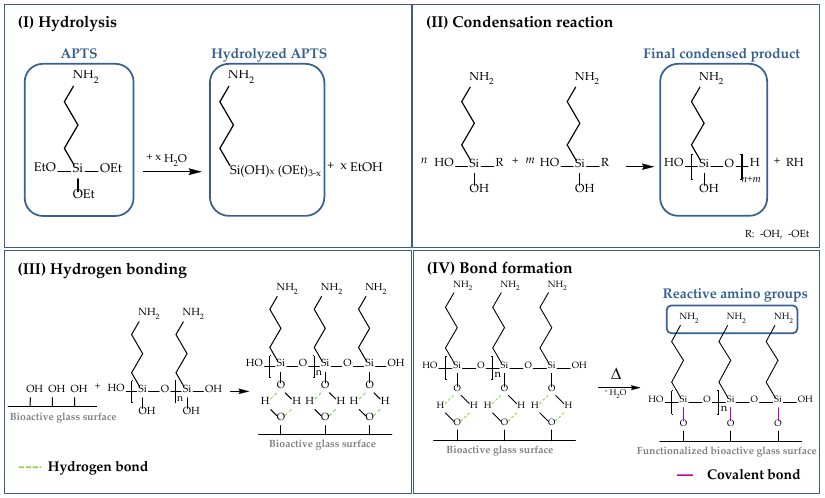
Figure 17. Surface functionalization of 45S5 bioactive glass-based scaffolds with APTS divided into ( I ) hydrolysis, ( II ) condensation reaction, ( III ) hydrogen bonding, and ( IV ) bond formation [50,54–56].